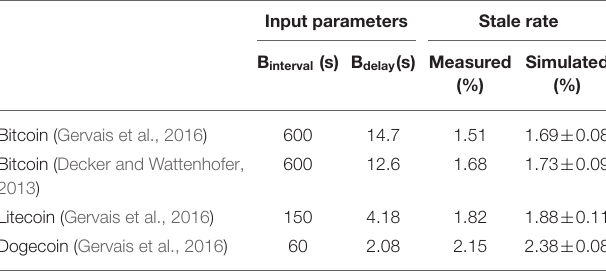
TABLE 4 | A comparison between BlockSim and previous studies in terms of the stale rate observed. Input